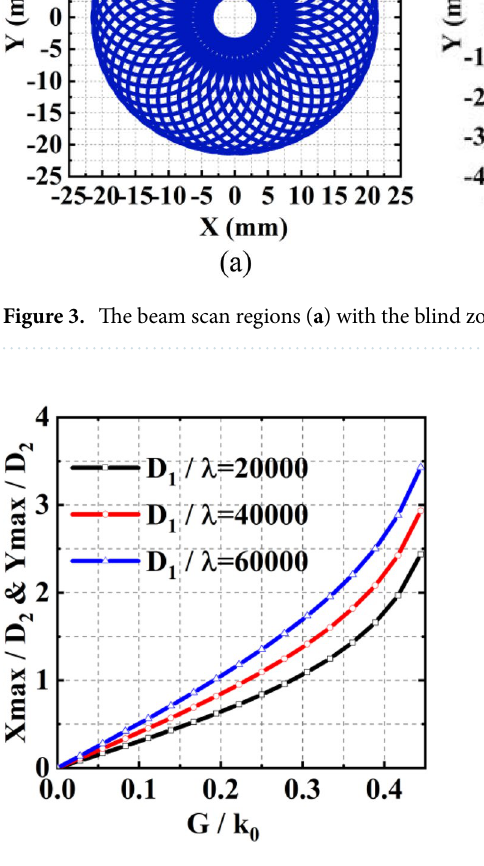
Figure 4. Influence of D 1 , D 2 , and G / k 0 on the beam scan region defined by ( X max , Y max